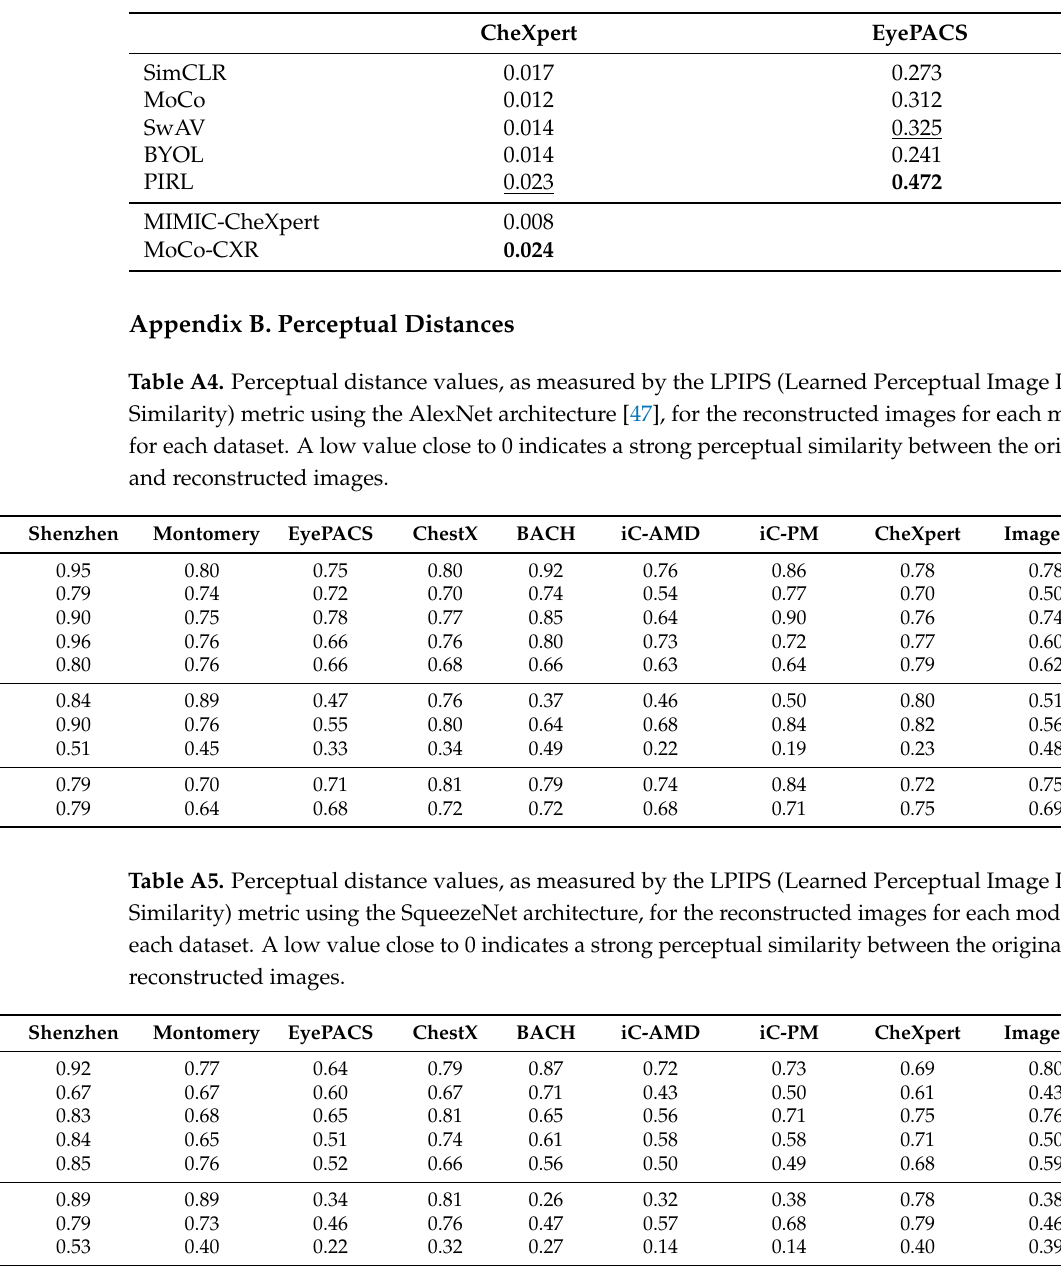
Table A3. Multi-view invariance evaluated on the CheXpert and EyePACS datasets, as measured by cosine similarity. Key: best , second best.